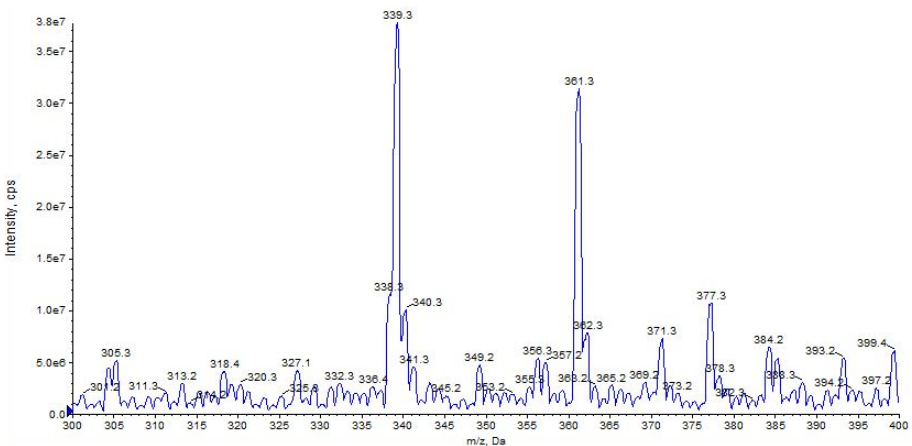
Figure 3 . Representation of alkali metal peaks of URB597 compound. Exponential scale to base 10. The fragment ion at m / z 214 is due to the loss of cyclohexyl isocyanate and that at m / z 197 is due to the loss of cyclohexyl isocyanate and ammonia (Figures 4 and 5, CE 20 V). Other fragment ions are those at m / z 322 due to the loss of ammonia from 339 and at m / z 171, which differs from the fragment at m / z 214 due to the loss of the carbamoyl group (Figure 4 and Figure 5).